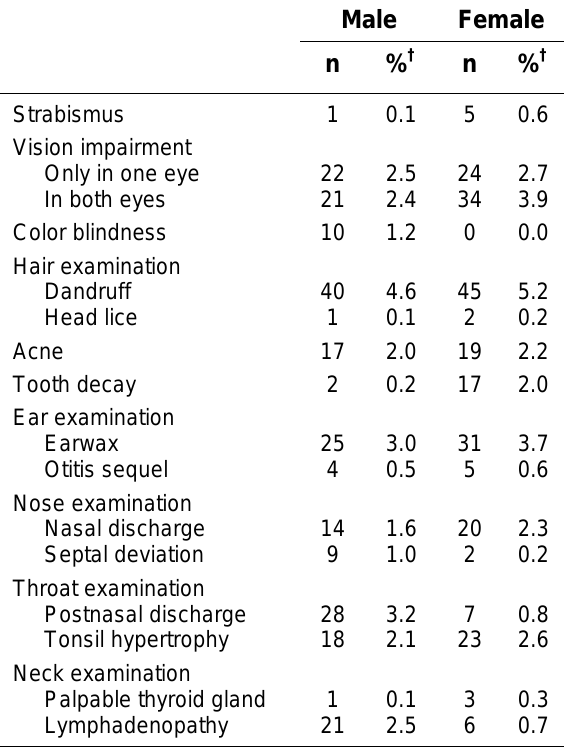
Physical Examination Findings According to